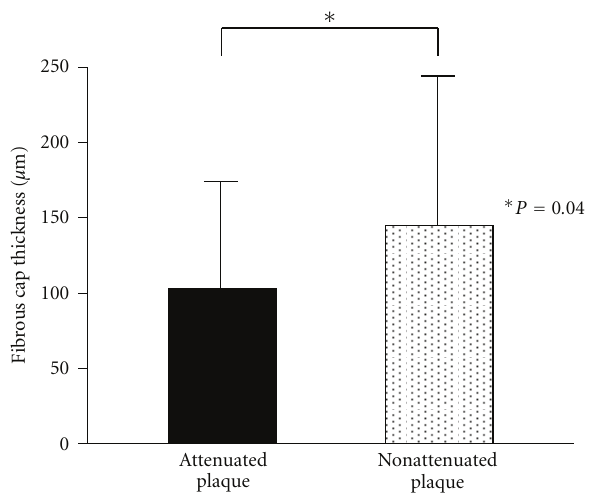
Figure 2: Comparison of fibrous cap thickness between attenuated plaques and nonattenuated plaques. In lipidic plaques, fibrous cap thickness as determined by OCT was significantly thinner in IVUS- detected attenuated plaques compared with nonattenuated plaques.